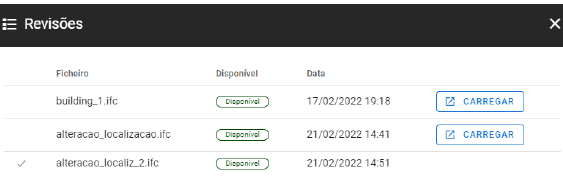
Figure 5. Georeferencing a 3D model in Editor.